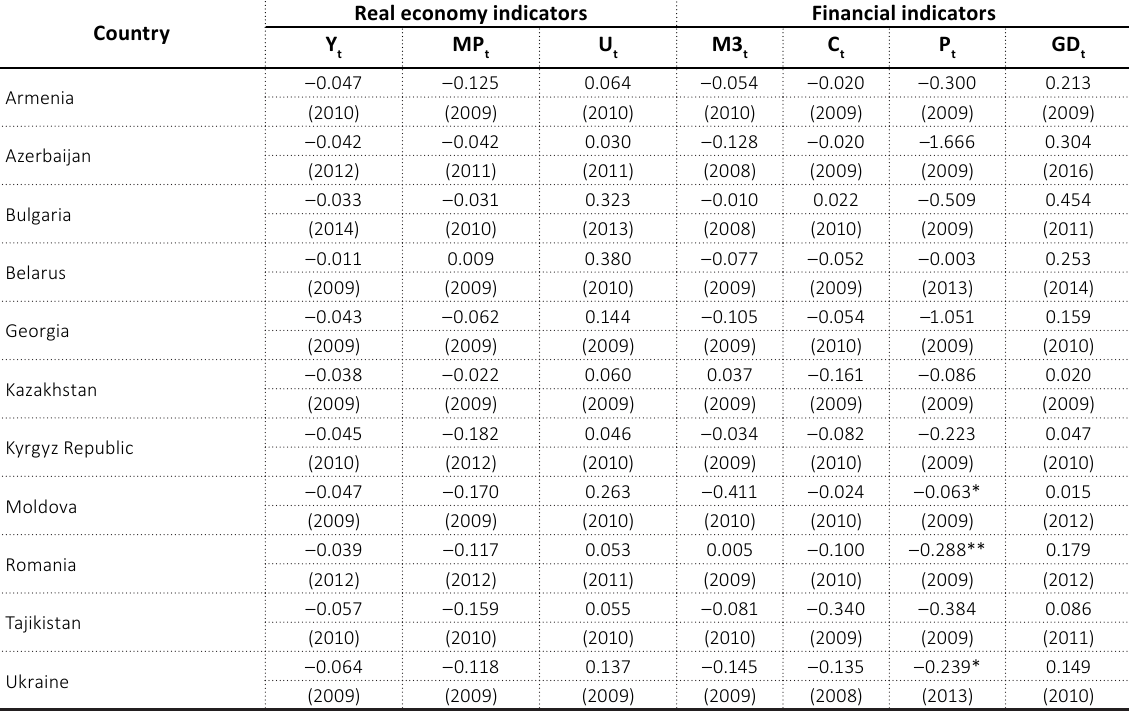
Table 2. Cycle troughs during financial crises of 2008 as natural